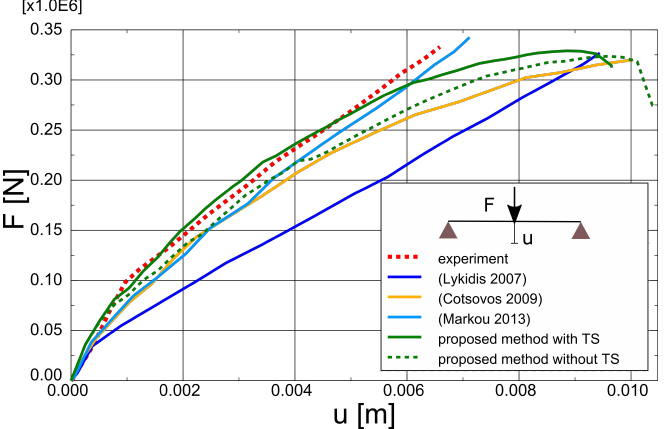
Figure 23. OA-1 beam—influence of TS.